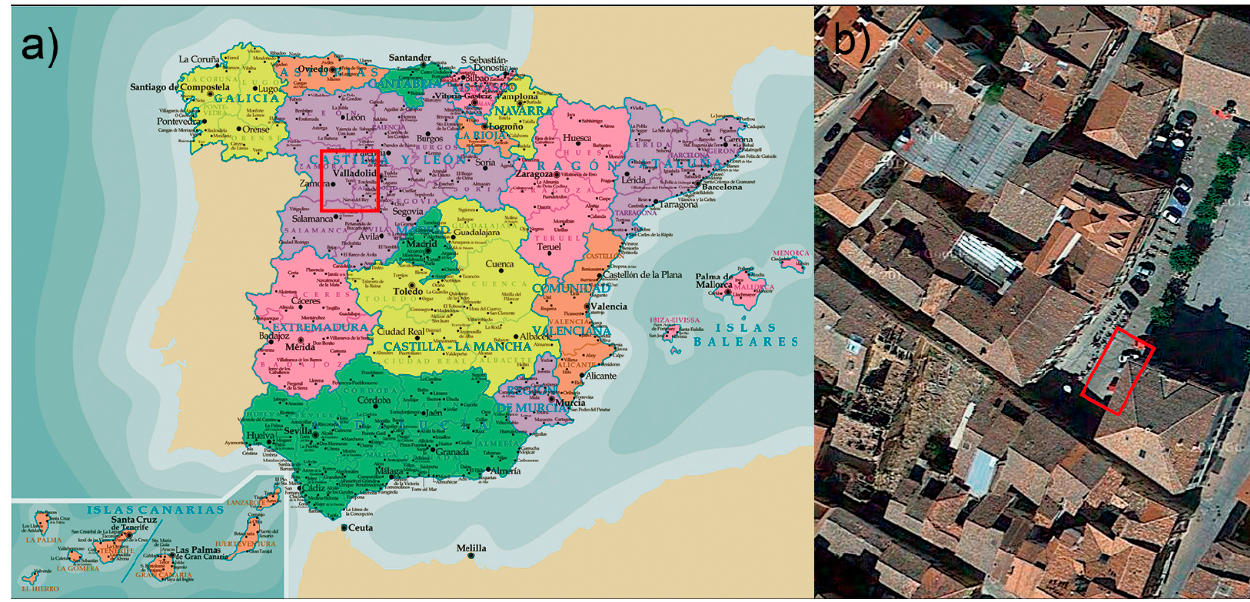
Figure 1. ( a ) Location of the wine cellar: Toro, Zamora, Spain; ( b ) top view and location of the “Toro’s Council” wine